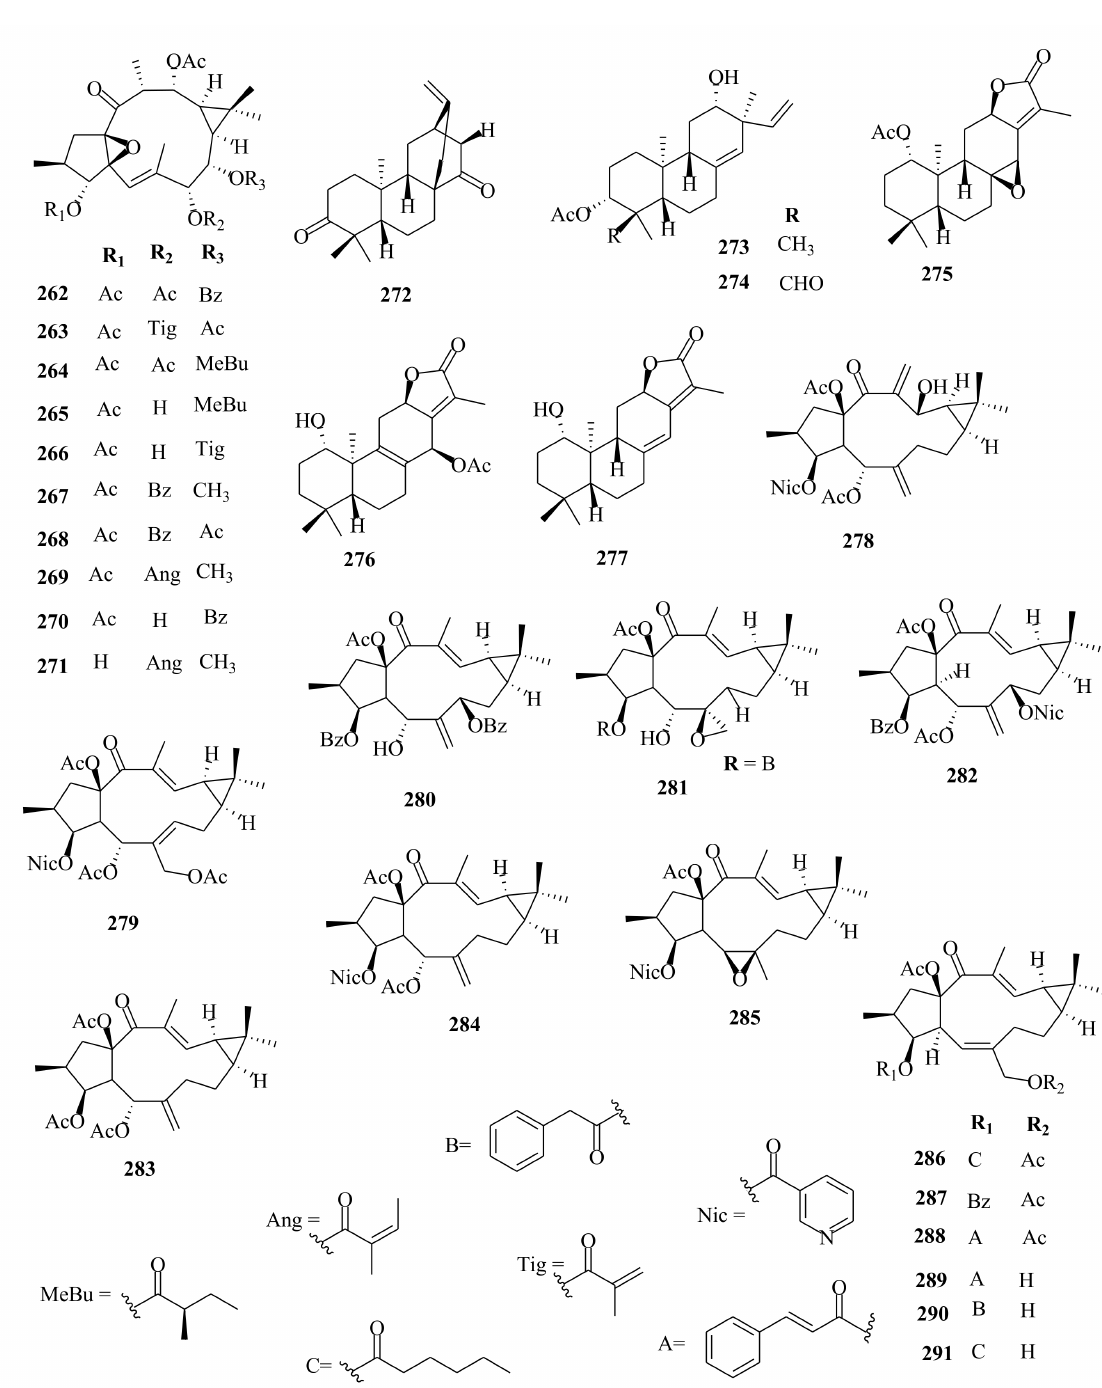
Figure 11. Chemical structures of Euphorbia kaurane and lathyrane